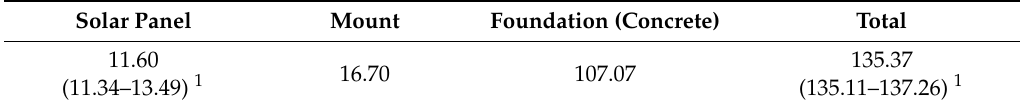
Table 4. Weight of PV equipment.